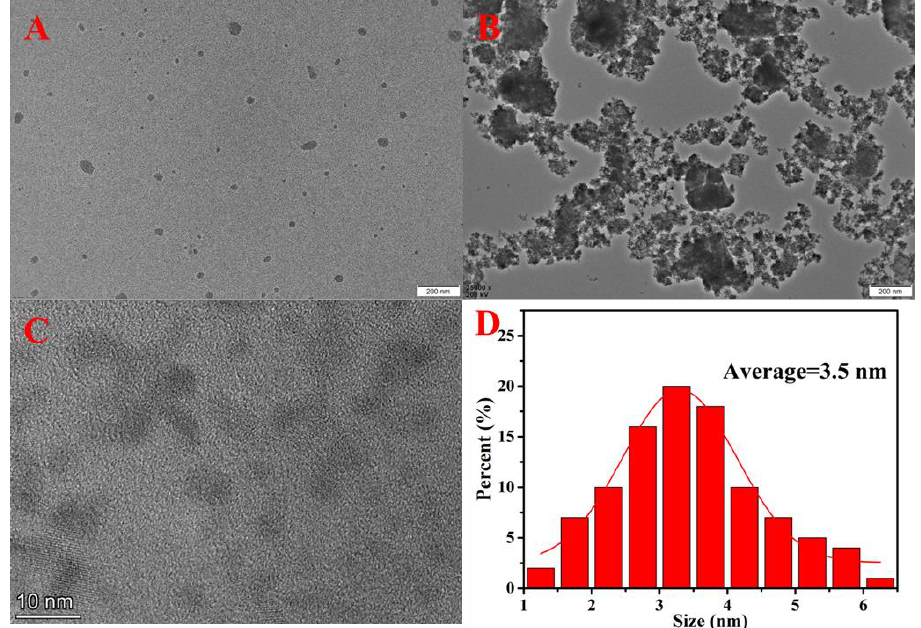
Figure 1. The TEM images of ( A ) LA − Cu NCs, ( B ) LA − Cu NCs@CS, ( C ) HRTEM image of LA − Cu NCs@CS, The diameter distributions histogram of ( D ) LA − Cu NCs@CS.